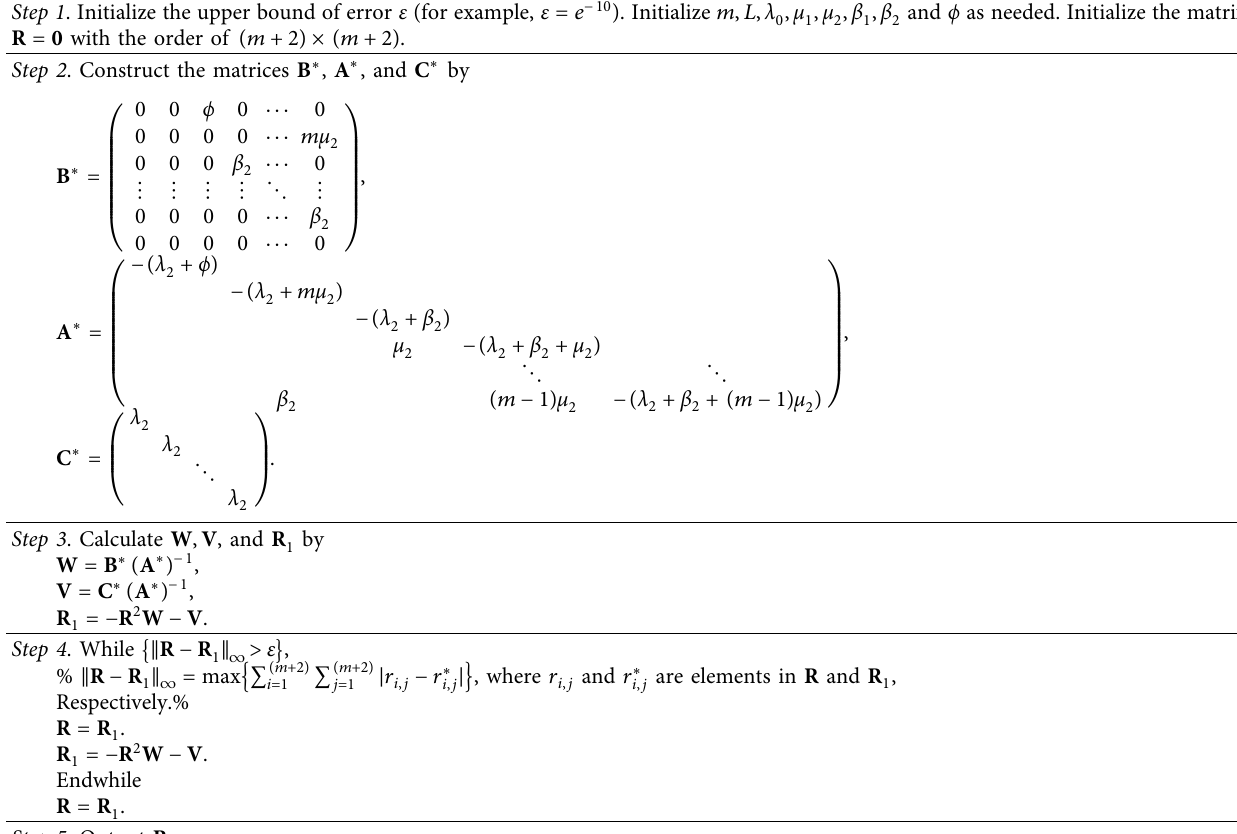
Table 1: Iteration algorithm to compute the rate matrix R